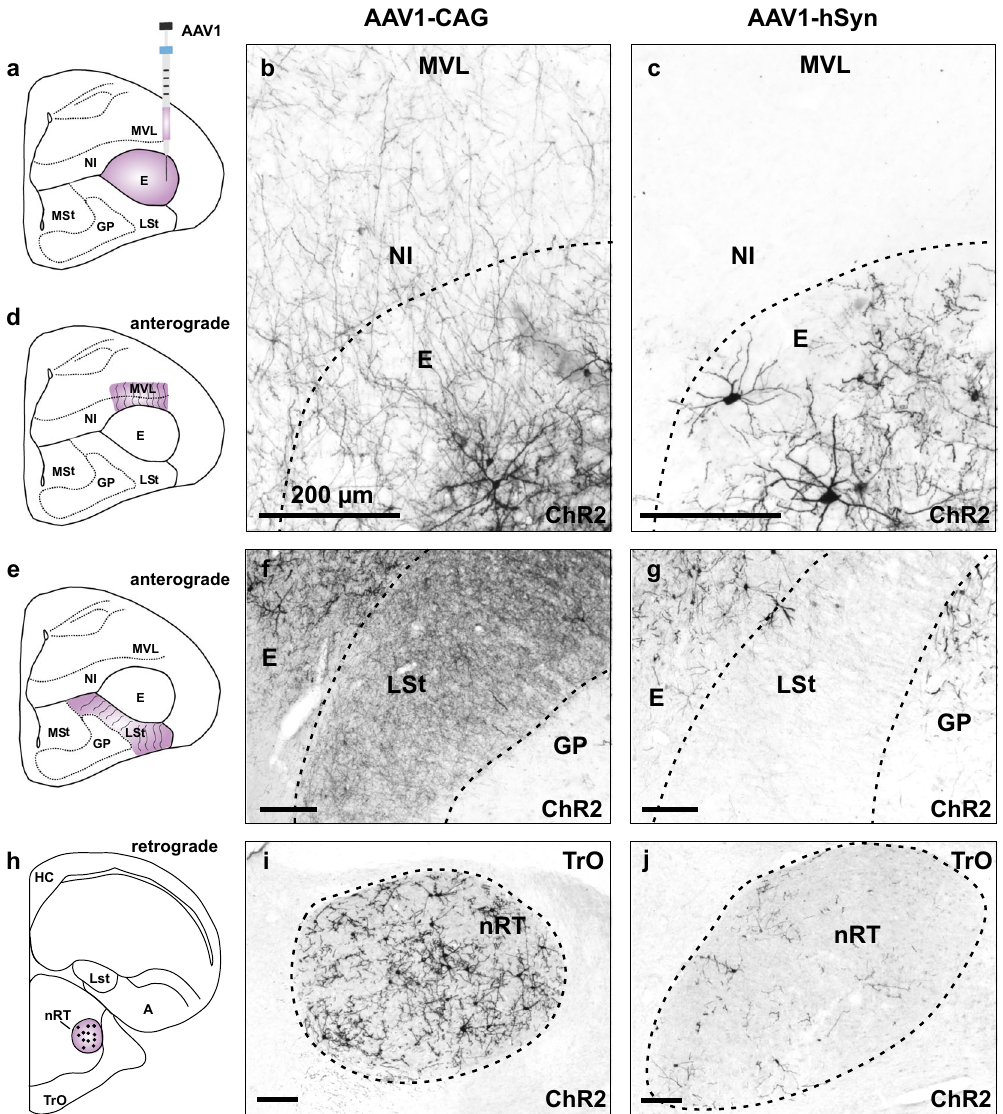
Fig. 2 Anterograde and retrograde ChR2 expression in target and input structures of the entopallium. a Schematic illustration of the injection area in the entopallium. b Anterograde ChR2 expression in fi bers projecting to the NI/MVL following injections of AAV1-CAG-ChR2. c Little anterograde ChR2 expression following injections of AAV1-hSyn-ChR2. d Schematic illustration of anterograde labeling in fi bers projecting to the NI/MVL. e Schematic illustration of anterograde labeling in fi bers projecting to the striatum. f Anterograde ChR2 expression in fi bers projecting to the striatum following injections of AAV1-CAG- ChR2. g Little anterograde ChR2 expression in the striatum following injections of AAV1-hSyn-ChR2. h Schematic illustration of ChR2 expression in the nucleus rotundus, which is the main input region of the entopallium. i Extensive retrograde ChR2 expression in the nucleus rotundus following injections of AAV1-CAG- ChR2 into the entopallium. j Scarce retrograde ChR2 expression in the nucleus rotundus following injections of AAV1-hSyn-ChR2. All scale bars represent 200 µ m. Note that images f , g , i , j have been rotated 90° to the left. Abbreviations: Arco arcopallium, E entopallium, GP globus pallidus, LSt lateral striatum, MSt medial striatum, MVL ventrolateral mesopallium, NI nidopallium intermedium, nRT nucleus rotundus, TrO tractus opticus.